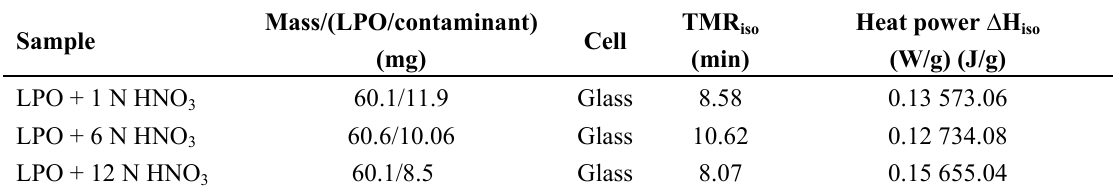
Table 5. Experimental data by TAM III tests for 95 mass% LPO with various concentrations of HNO at 80 3